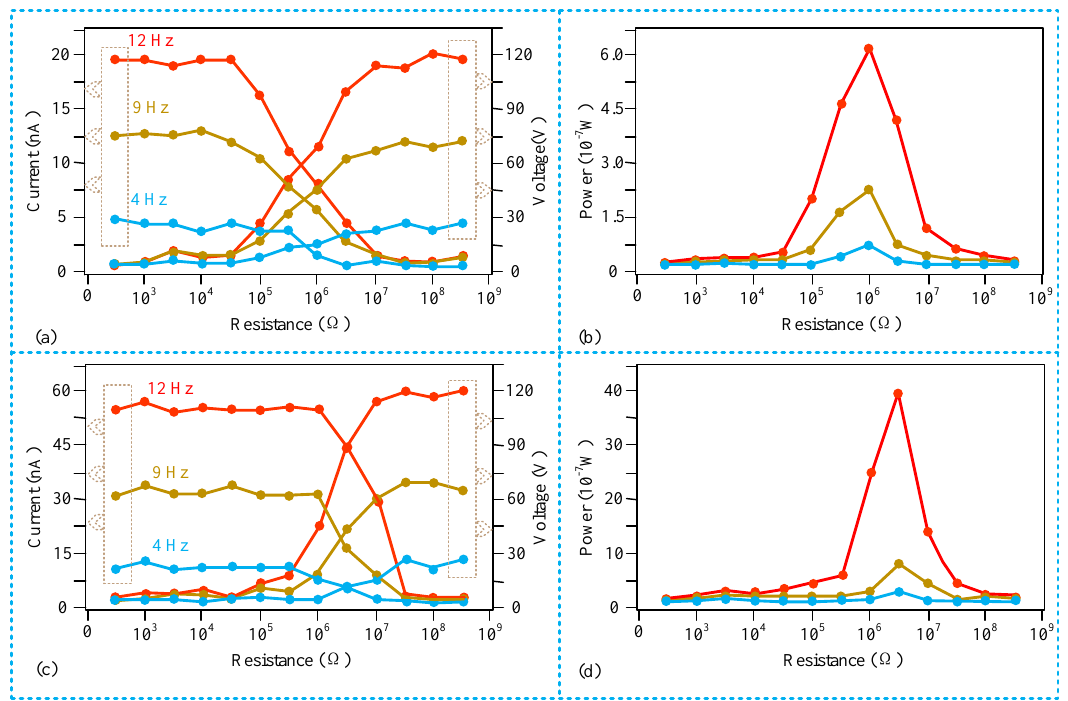
Figure 5. Power-generation performance of the RSV − TENG. ( a ) Output voltage and current of a single RSV−TENG under different external resistances; ( b ) output power of a single RSV−TENG under different external resistances; ( c ) output voltage and current of three RSV − TENGs under different external resistances; and ( d ) output power of three RSV − TENGs under different external resistances.